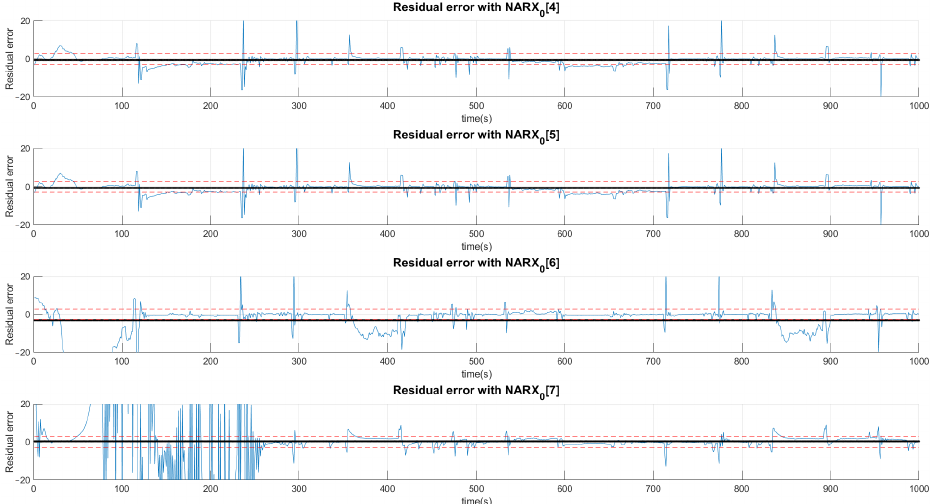
Figure 12. Production of plant residues when NARX networks expert to Faults F4, F5, F6 and F7 are used. All of these are produced in the first layer (Layer 0) of the decision